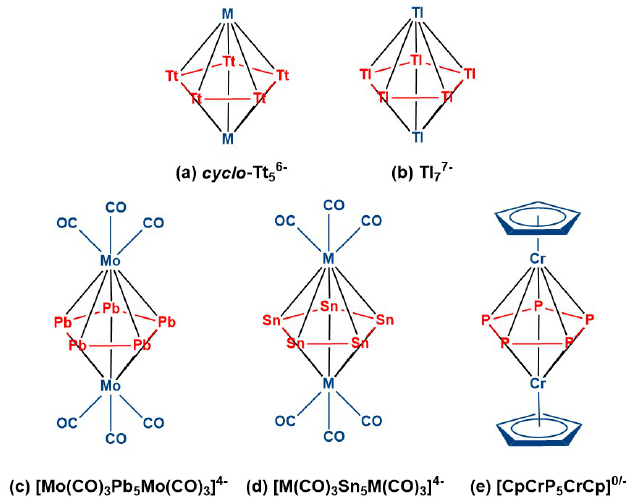
Figure 1. Examples of pentagonal bipyramidal cluster architectures from the transition metal series and main-group: ( a ) cyclo -Tt 6 − in the binary phase K (M = Cr, Mo), this work and ( e ) [CpCrP